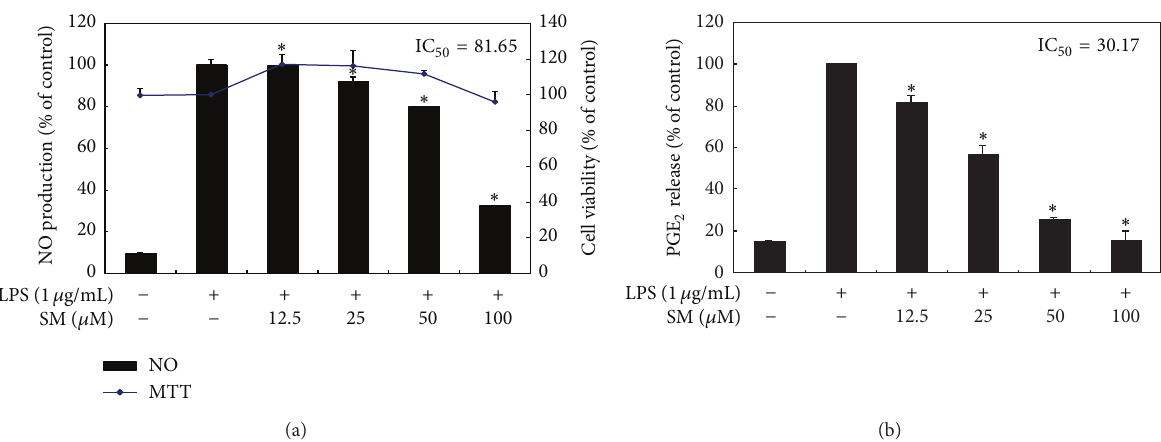
Figure 2: Effect of sargachromenol on NO production in LPS-stimulated RAW 264.7 cells. Cells were stimulated with 1 𝜇 g/mL of LPS only or with LPS plus the indicated concentrations of SM for 24h. NO (a) levels were determined by the Griess reagent method. PGE 2 (b) levels were measured using an ELISA kit. The data represent the mean ± SD of triplicate experiments. ∗ 𝑃 < 0.05 , ∗∗ 𝑃 < 0.01 versus LPS alone. Cell viability was determined from the 24 h culture of cells stimulated with LPS (1 𝜇 g/mL) in the presence of SM. NO: nitric oxide; LPS: lipopolysaccharide; SM: sargachromenol; PGE 2 : prostaglandin E 2 ; ELISA: enzyme-linked immunosorbent assay.